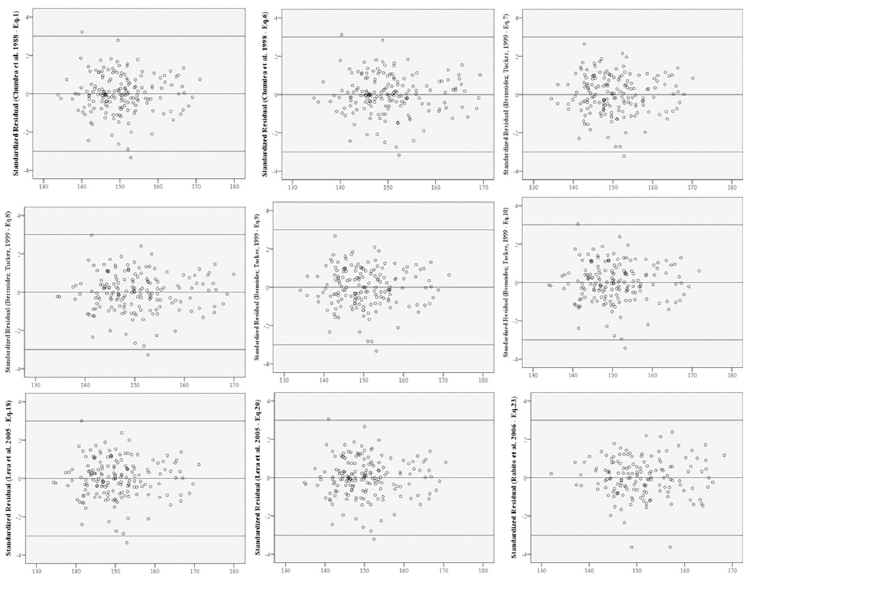
Fig 3. Bland-Altman plot of the height-estimation equations, Brazil,